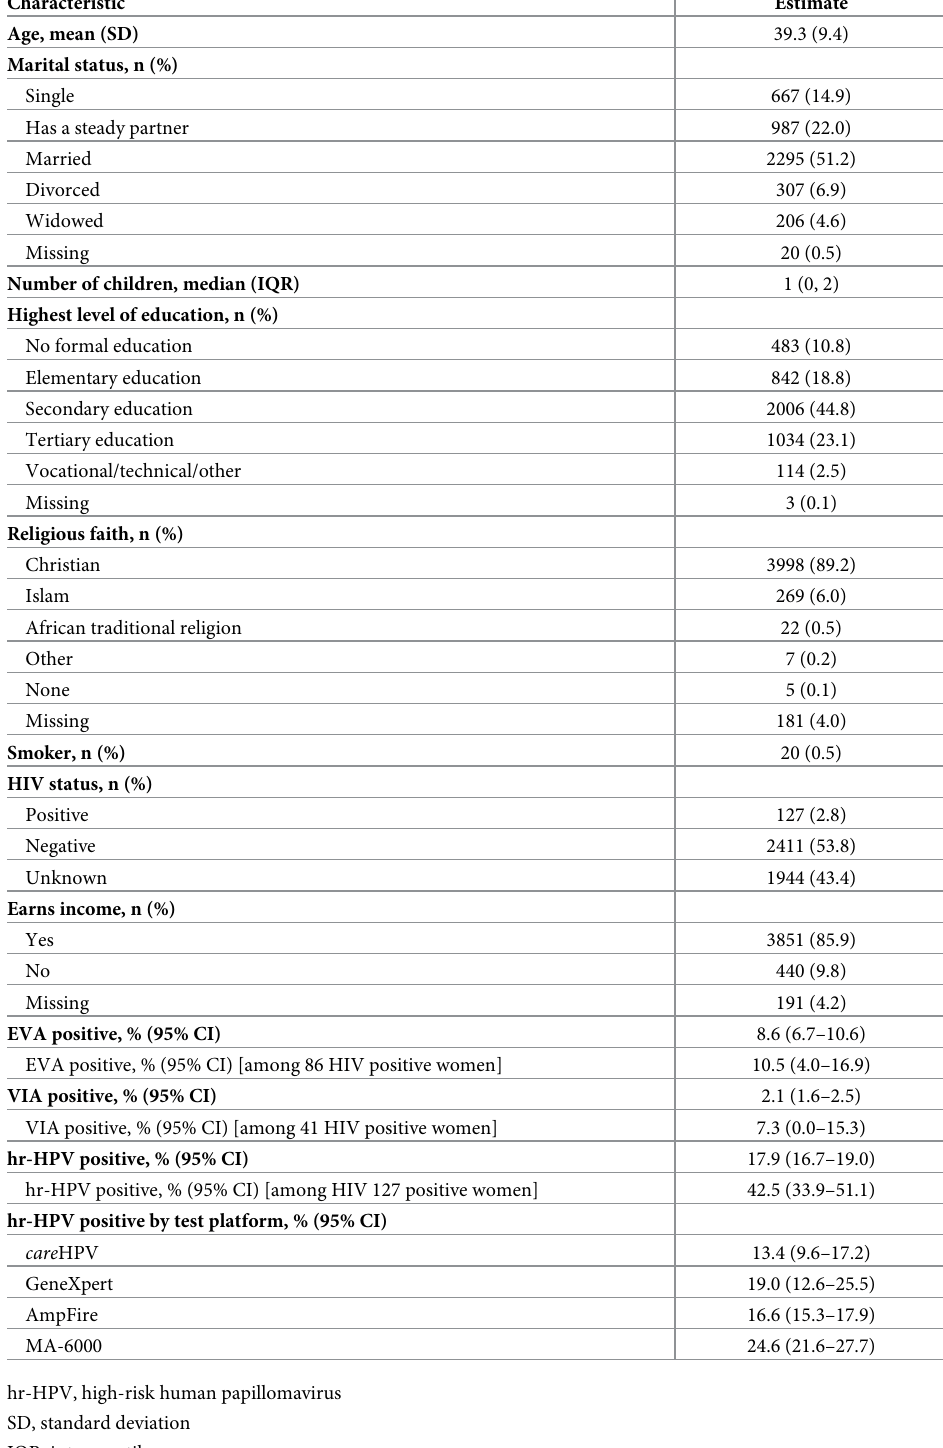
Table 1. Sociodemographic and clinical characteristics of women (n = 4482) who underwent concurrent cervical precancer screening via HPV DNA testing and visual